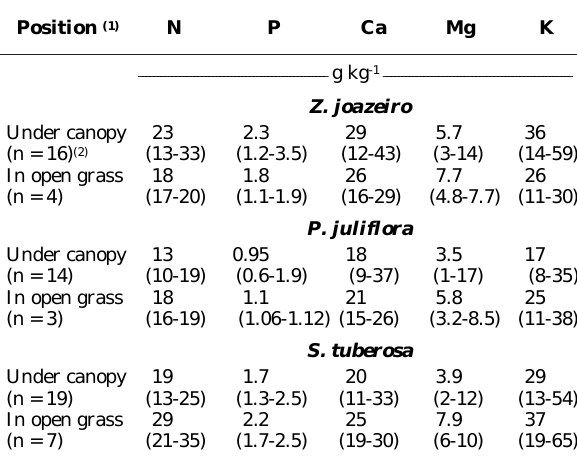
Table 3. Mean values (1) of grass ( C. ciliares ) tissue nutrient concentration under and outside (open grass) the canopy area of Z. joazeiro , P. juliflora , and S. tuberosa trees